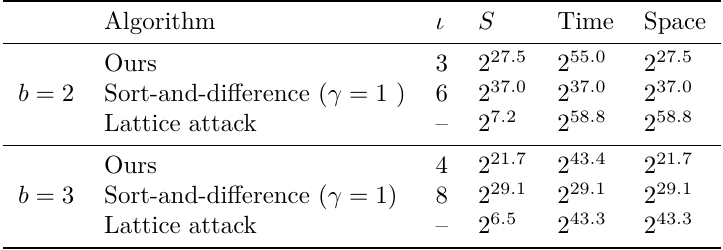
Table 3: Estimates for the minimum required number of signatures and the optimal complexities of reduction algorithms and a lattice attack when λ = 252. The estimates omit the subexponential factors; note however, that those factors are the same for sort- and-difference and our algorithm, and are worse for a lattice